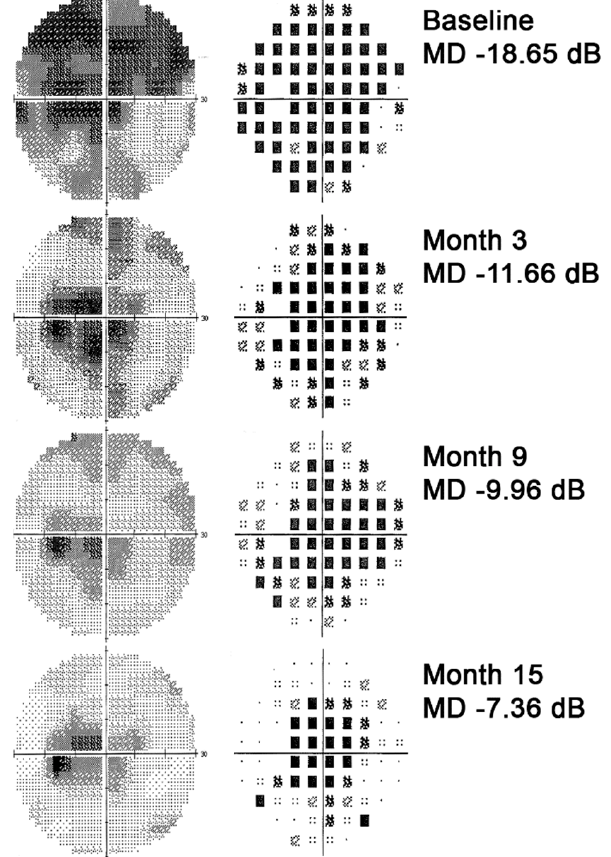
Figure 4. Visual field series from the left eye of a late chronic LHON patient during idebenone treatment. Grayscale and total deviation maps from baseline and follow-ups at month 3, 9 and 15. A continuous reduction of central scotoma size and depth was seen during treatment. The patient had the LHON mutation m.13051G>A. Idebenone treatment was initiated 13 years after LHON onset.